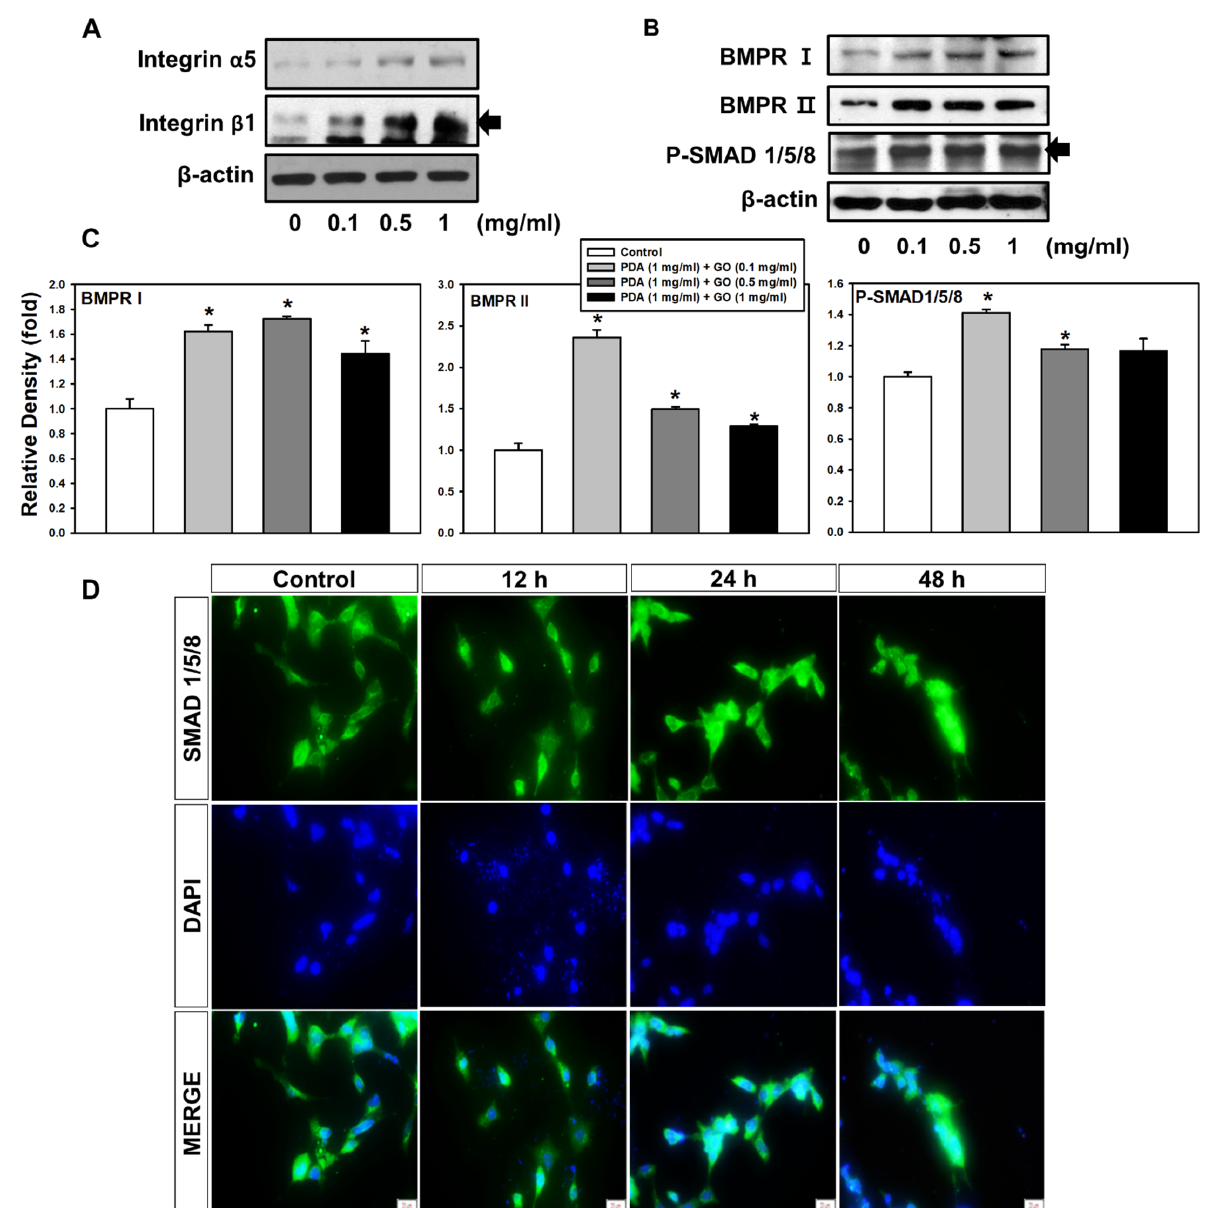
Figure 4. Effect of PDA/GO on integrin α 5/ β 1, MAPKs, BMPR I/II, and SMAD 1/5/8 signaling pathways. The cells were cultured on the PDA/GO substrate for 7 days, and the protein levels of ( A ) integrin α 5 (138 kDa), integrin β 1 (150 kDa), and ( B ) BMPR I (50–55 kDa), BMPR II (115 kDa), and phosphorylation levels of SMAD 1/5/8 (52–56 kDa) were analyzed. ( C ) The bars denote the density relative to β -actin. The values are expressed as means ± SD ( n = 3). * p < 0.05 vs. control value. ( D ) Nuclear translocation of SMAD 1/5/8 was assessed by immunofluorescence staining (scale bar, 20 μ m).